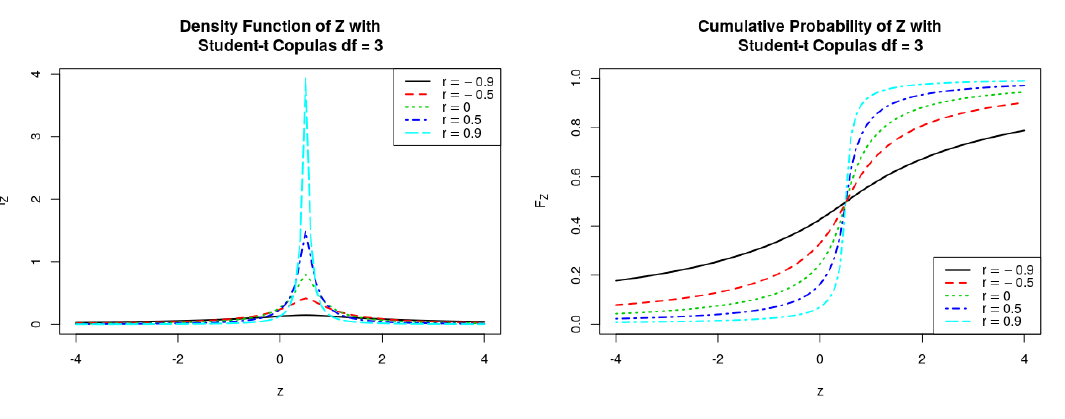
Figure 4. PDFs and CDFs of the ratio Z